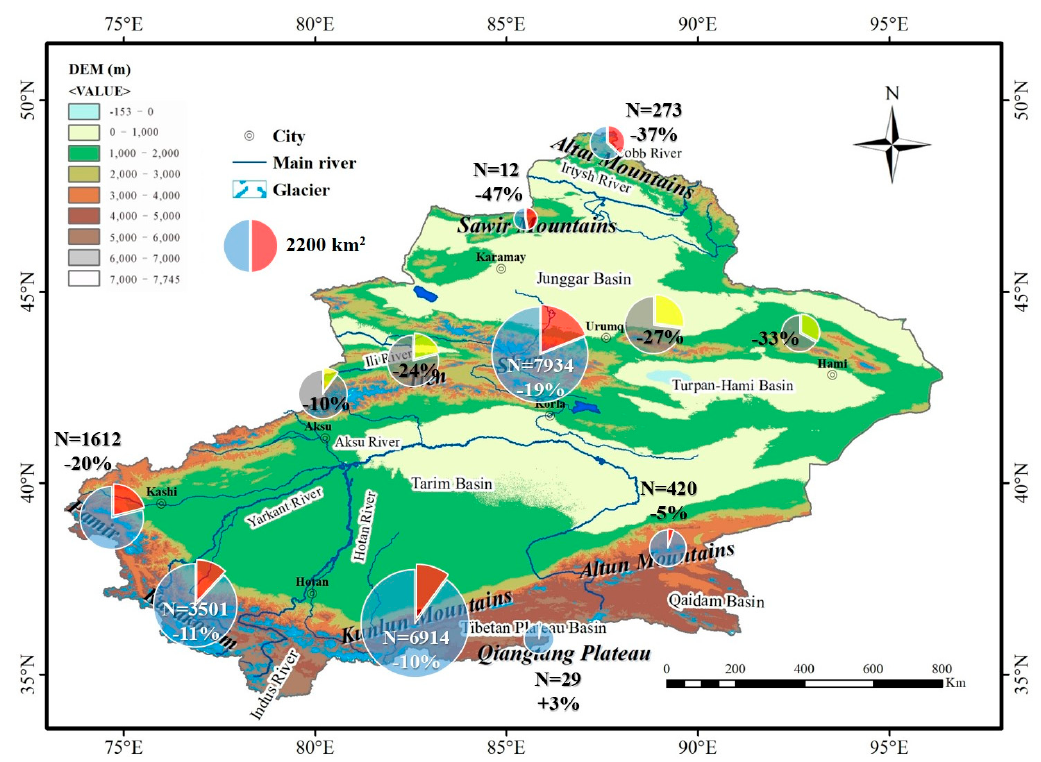
Figure 2. Glacier area changes in the different mountain ranges in Xinjiang from the 1960s to 2000s. The area change percentage is indicated by red portion in the blue circle; the size of the circle reflects the glacier area in the 1960s. N represents the number of glaciers in different mountain ranges according to the second Chinese Glacier Inventory [31–33]. The four gray circles with yellow portion show the glacier changes in drainage basins of glaciers in Tien Shan, including the Aksu River Basin, Ili River Basin, Junggar Basin, and Turpan-Hami Basin from west to east.